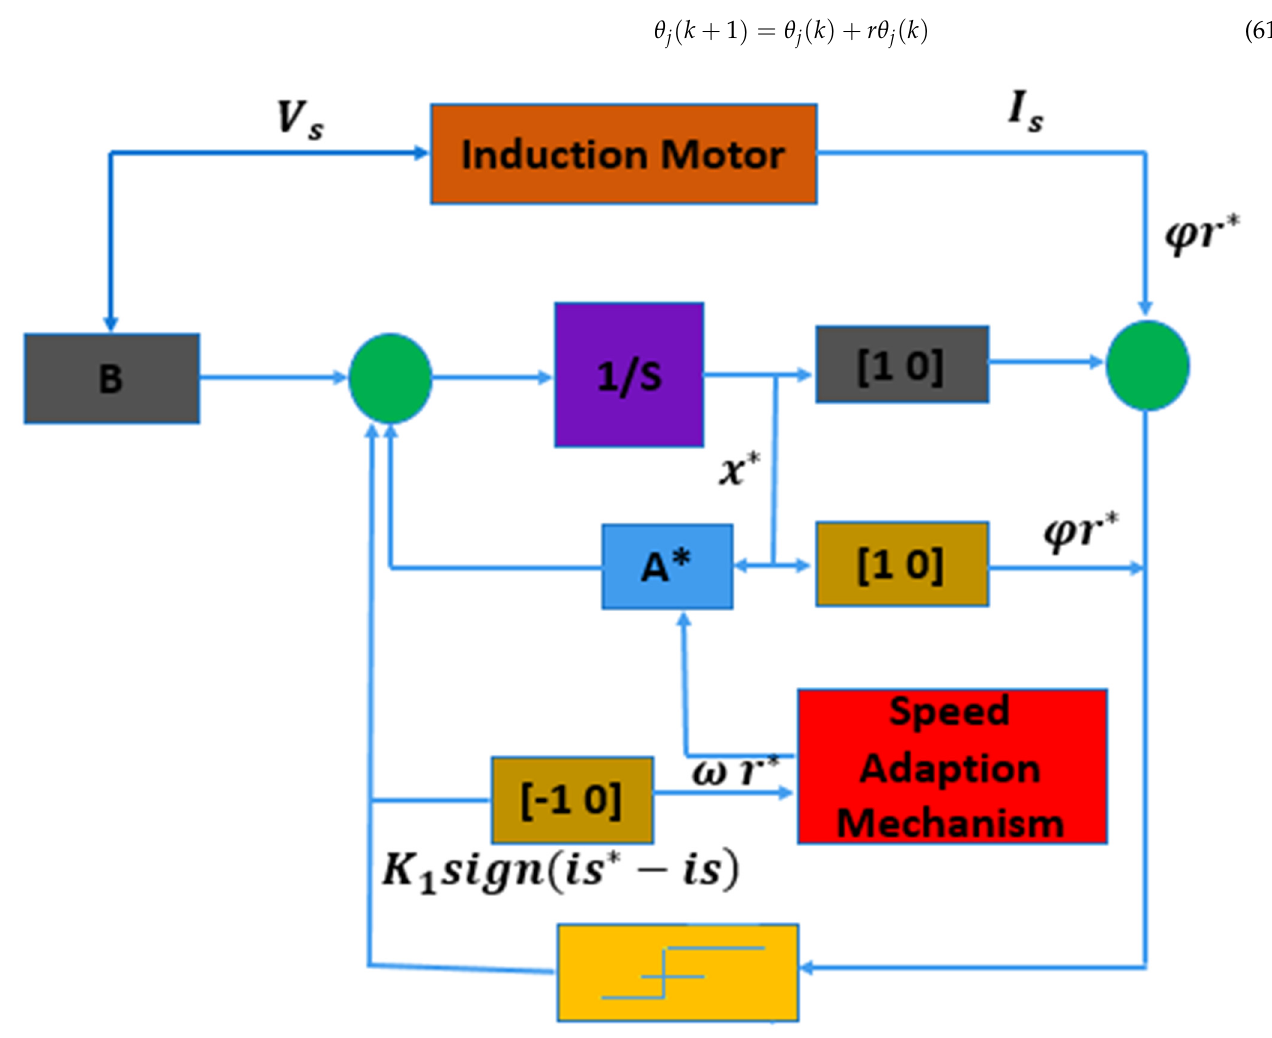
Figure 16. Sliding mode observer.